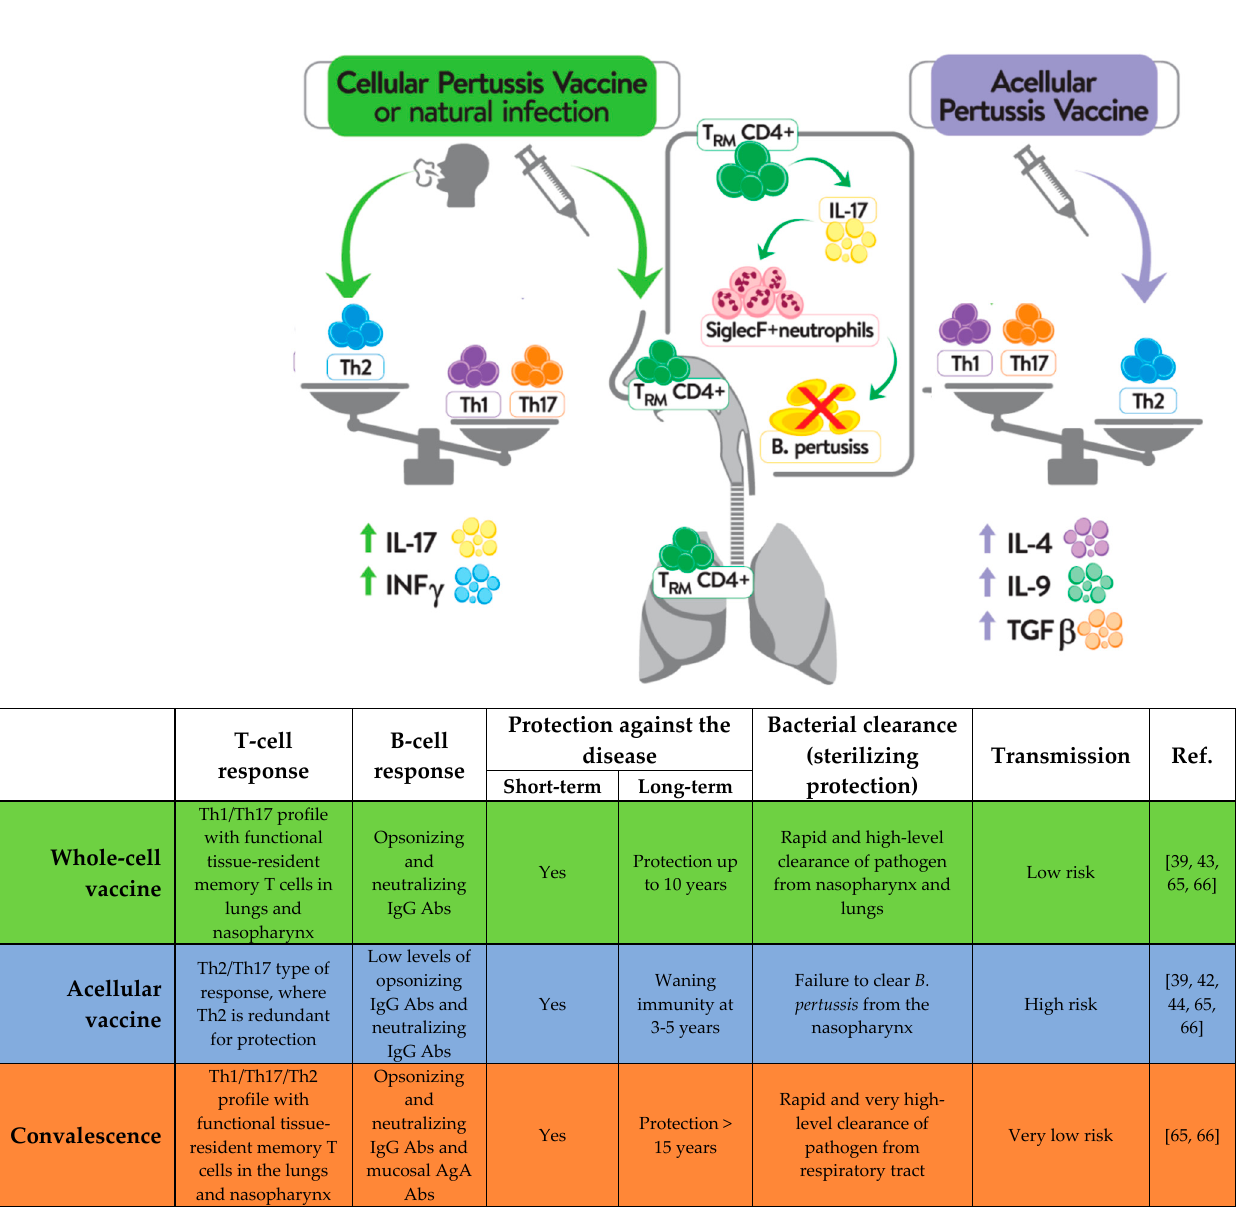
Figure 2. Different immune response to natural B. pertussis infection and immunization with vaccines containing a whole-cell pertussis component or an acellular pertussis component.